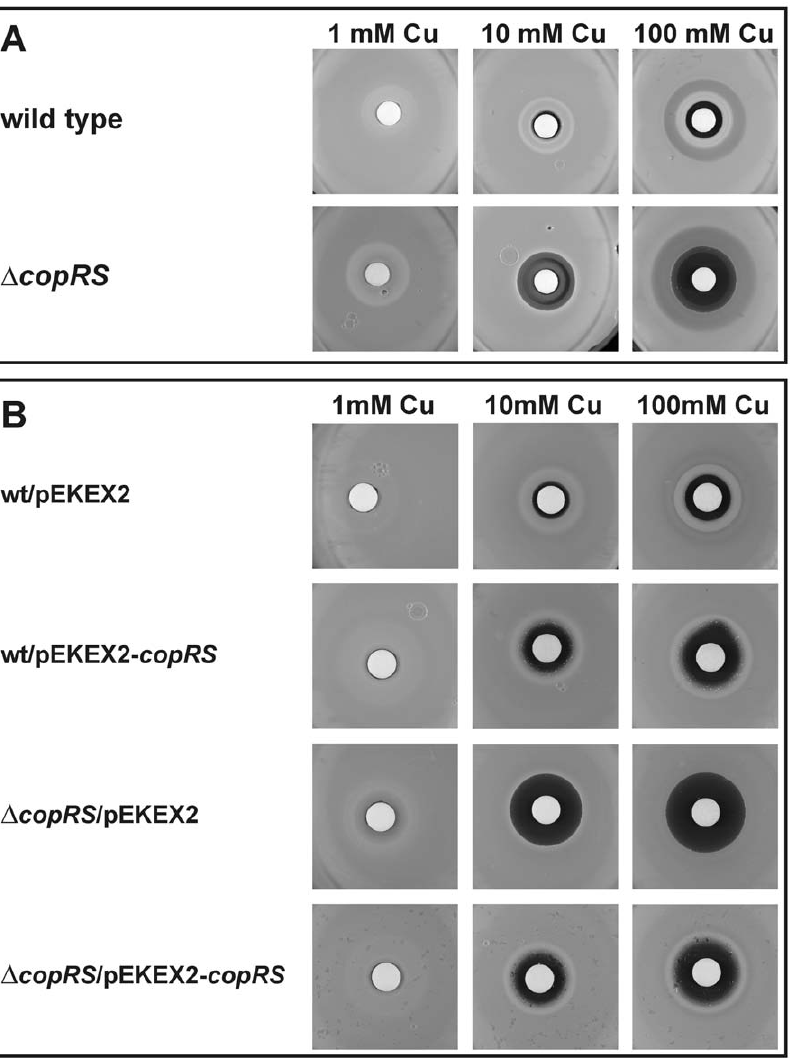
Figure 2. Agar diffusion assays showing growth inhibition of different C.glutamicum strains by copper ions. (A) Comparison of the copper sensitivity of C. glutamicum wild type and the D copRS deletion mutant. The inhibition zone (black halo) increased with higher copper concentrations and was larger for the deletion mutant. (B) The copRS deletion can be complemented using the plasmid encoded copRS genes. For experimental details see Material and